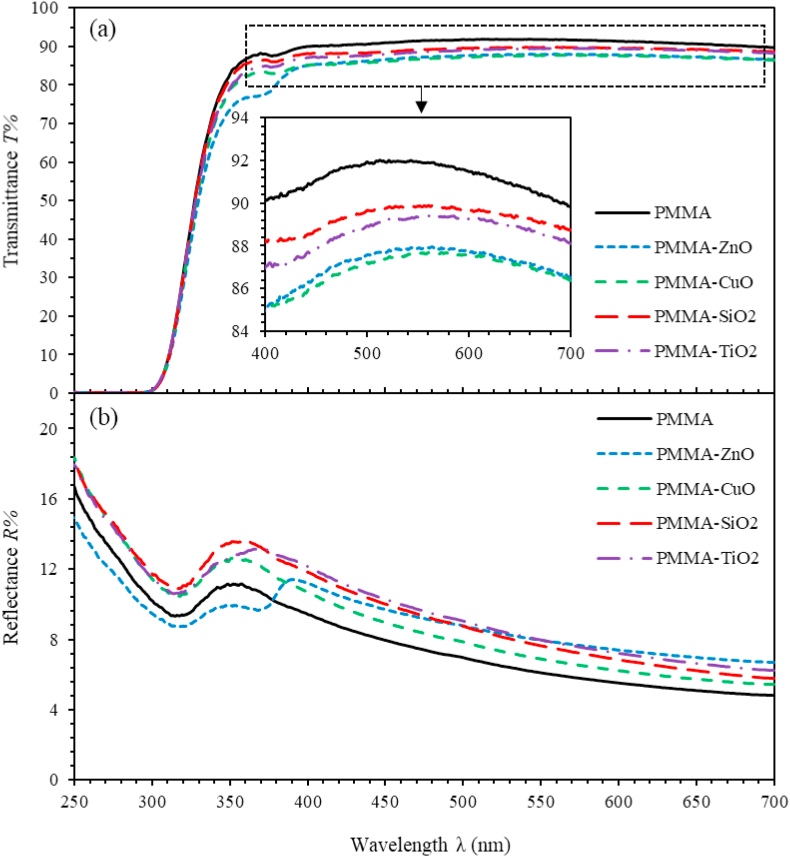
(a) Transmittance spectra and (b) Reflectance spectra of the PMMA and PMMA incorporated with ZnO, CuO, SiO2 and TiO2 NPs nanocomposites thin films as a function of wavelength.